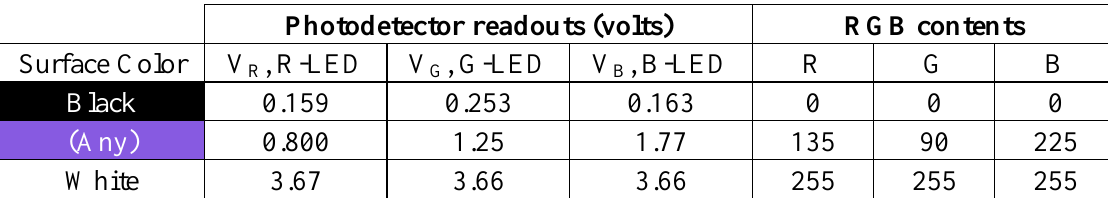
Table 1. Typical photodetector readout in terms of analog voltages depending on RGB contents of the